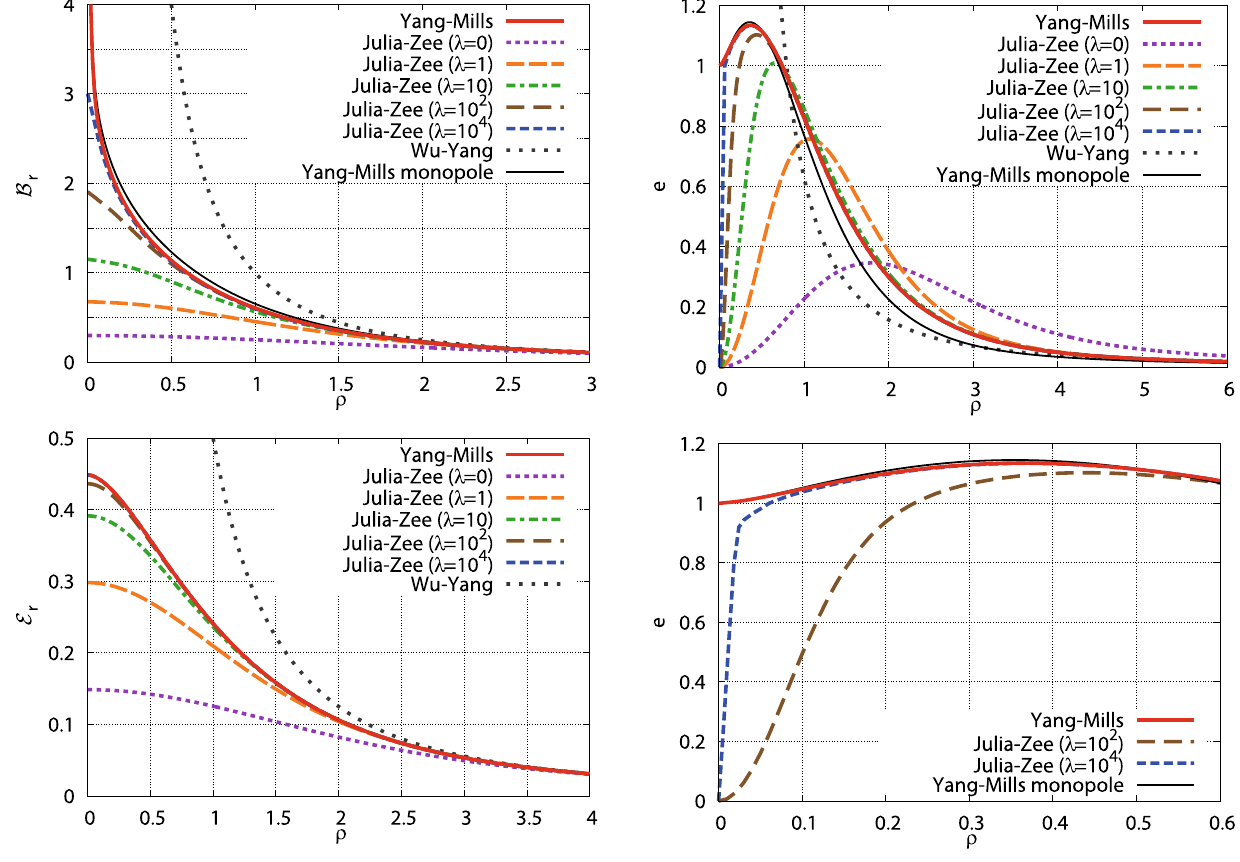
0 . 5, which should be compared with the Julia–Zee solution.